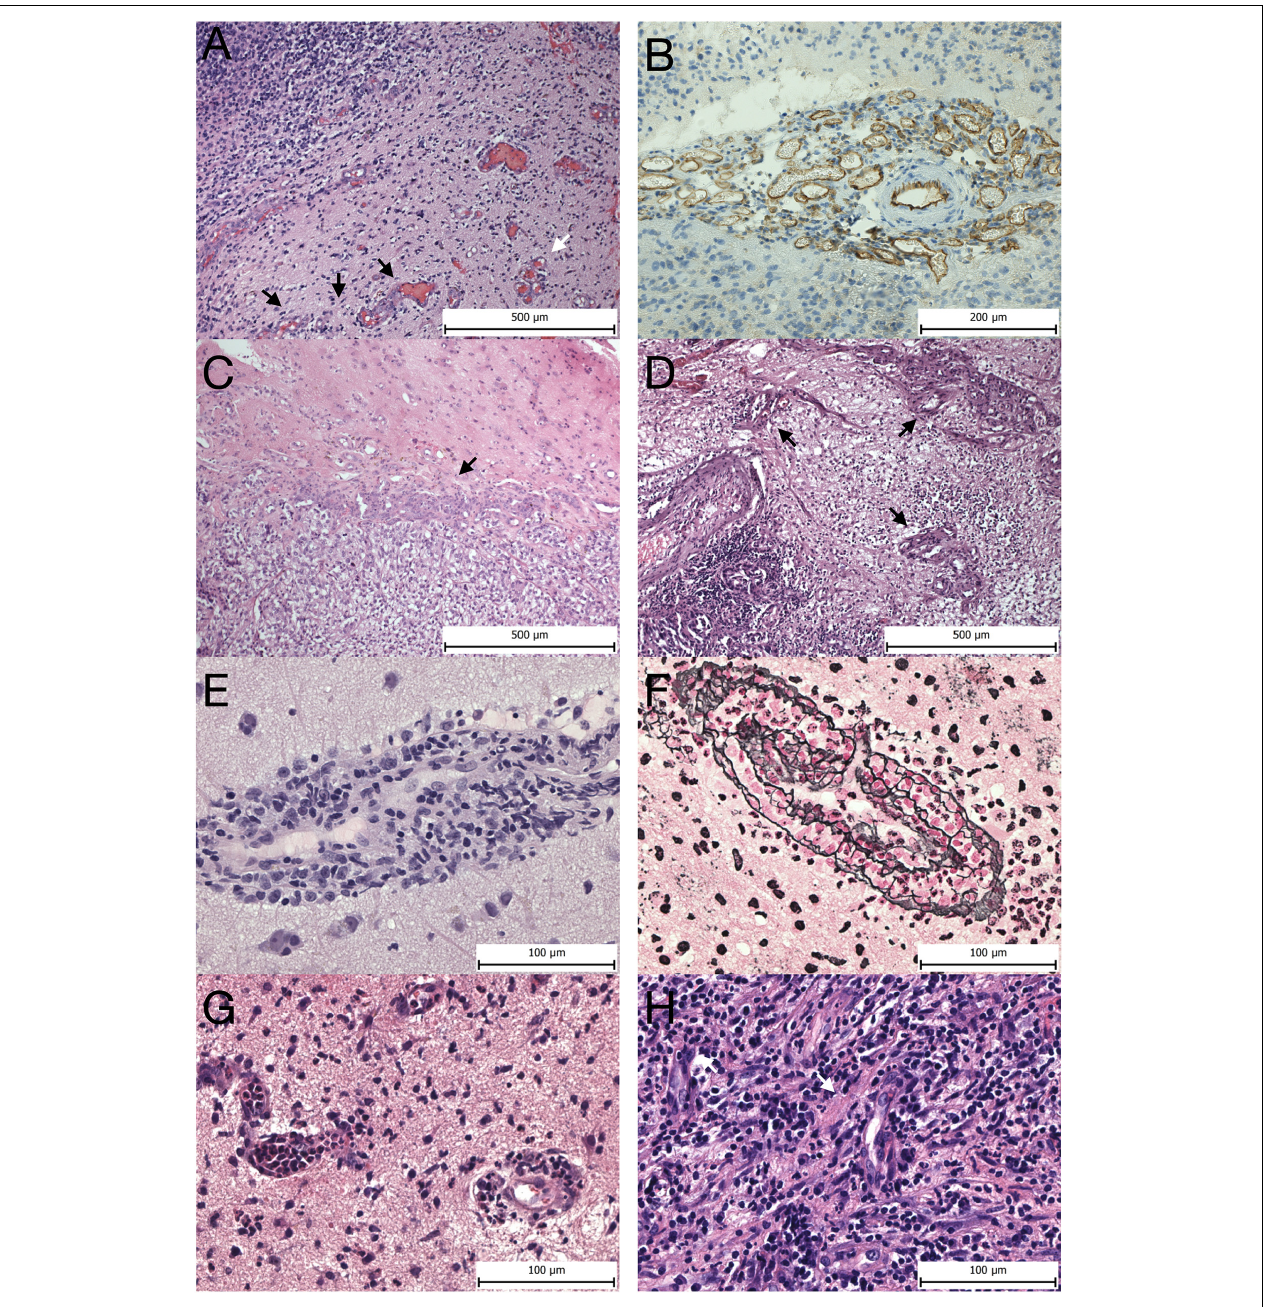
FIGURE 2 | Vascular morphology. Microvascular proliferations at the invasive edge of GBM— (A) glomeruloid vascular proliferation (white arrow) and vascular garlands (black arrows). (B) CD31 expression in a vascular garland seen by immunohistochemistry. (C) Metastasis of clear cell renal cell carcinoma to the brain seen on the right side surrounded by microvascular proliferation (arrow). (D) Pulmonary non-mucinous adenocarcinoma metastatic to the brain (bottom left corner) surrounded by multiple glomeruloid microvascular proliferations (arrows). (E) Perivascular infiltration of the PCNSL intermingled with reactive lymphocytes forming vascular cuffs. (F) Reticulin-specific stain highlights the complex reticulin web encompassing the tumor cell caused by neoplastic lymphoid cells penetrating through the vascular wall. (G) Vessels in acute abscess in the brain with leukostasis and neutrophil transmigration across the BBB. H, vessels in chronic abscess display reactive pericytes prominently (white arrows), and no microvascular proliferations are seen. Panels (A–D) magnification 100x, panels (E–H) magnification